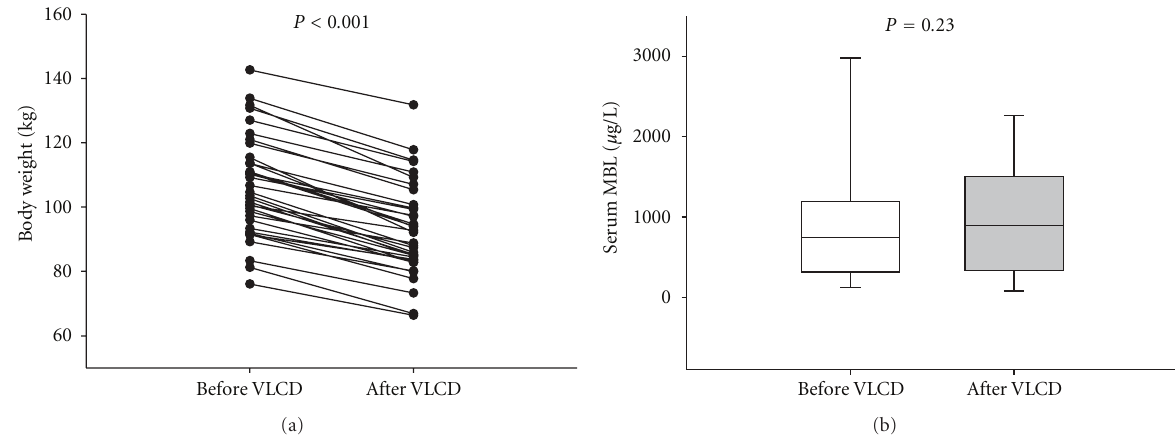
Figure 1: (a) Body weight before and after VLCD. (b) Serum MBL before and after VLCD.